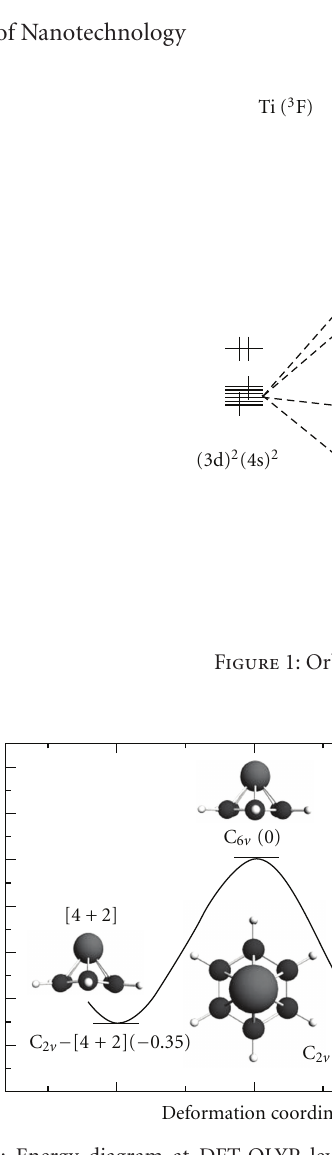
Figure 2: Energy diagram at DFT-OLYP level of the calculated C 6 H 6 -Ti triplet configurations. The smooth line is a pure schematic guide between the three configurations. Hydrogen, carbon, and titanium atoms are shown in white, dark grey, and light grey,